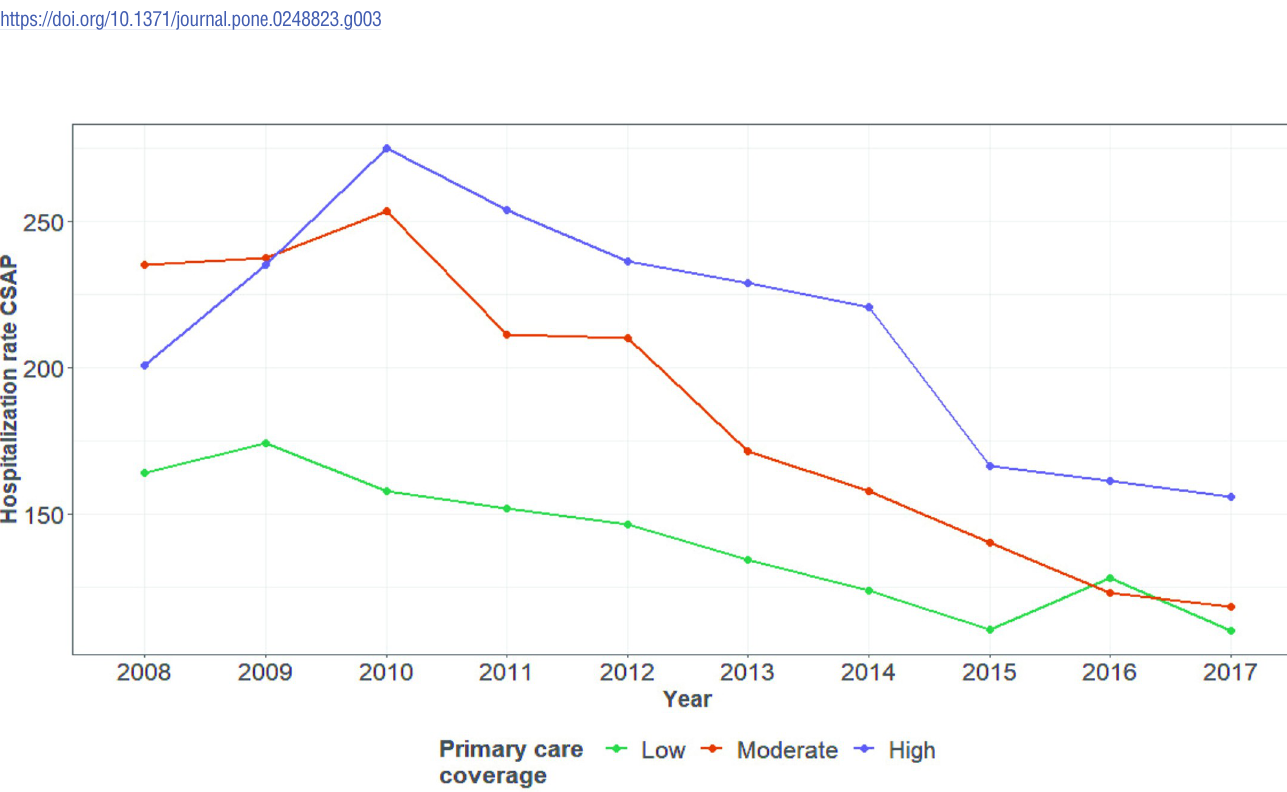
PLOS ONE | https://doi.org/10.1371/journal.pone.0248823 April 8,